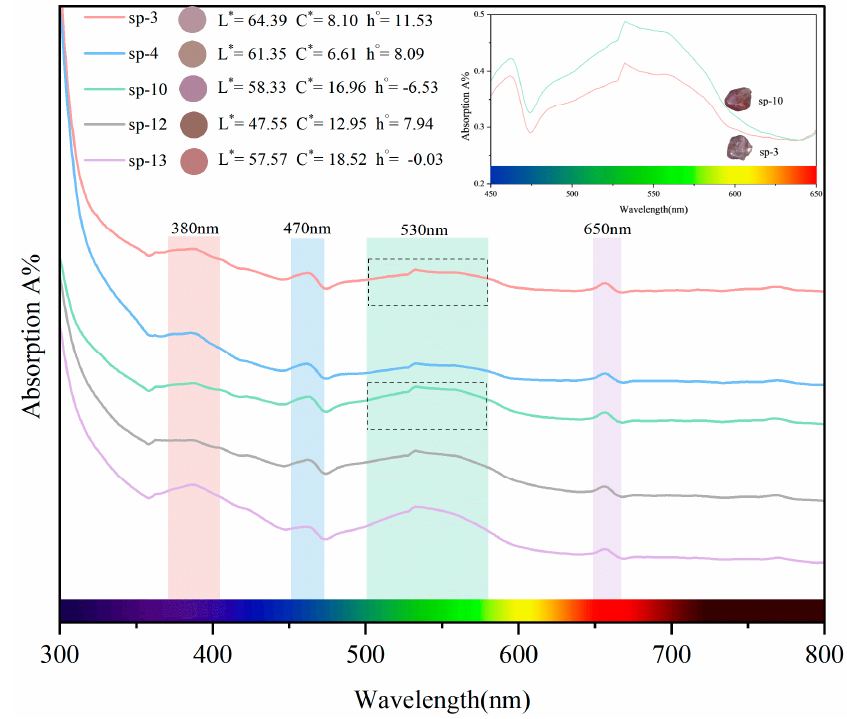
Figure 6. UV-Vis absorption spectra of iron-bearing spinel.